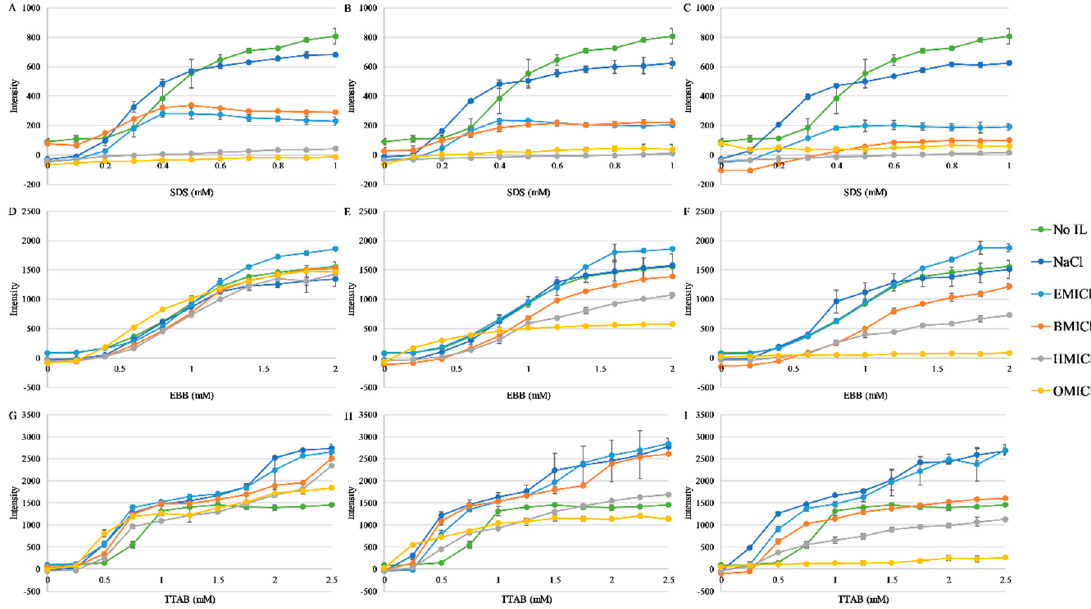
Figure 4. Dissociation of heme from myoglobin by fluorescence dequenching. Data are the emission intensity of the sample with λ ex = 280nm, λ em = 340nm. Color coding for each IL or control is indicated in the figure. Panels ( A – C ) are with SDS, ( D – F ) are with EBB, and ( G–I ) are with TTAB. Panels ( A ), ( D ), and ( G ) (left column) are supplemented with 50 mM of RTIL; panels ( B ), ( E ), and ( H ) are supplemented with 150 mM RTIL; panels ( C ), ( F ), and ( I ) are supplemented with 300 mM RTIL. Data represent the average of at least three replicates, error bars represent the standard deviation, and lines are not fits but are only to guide the eye.